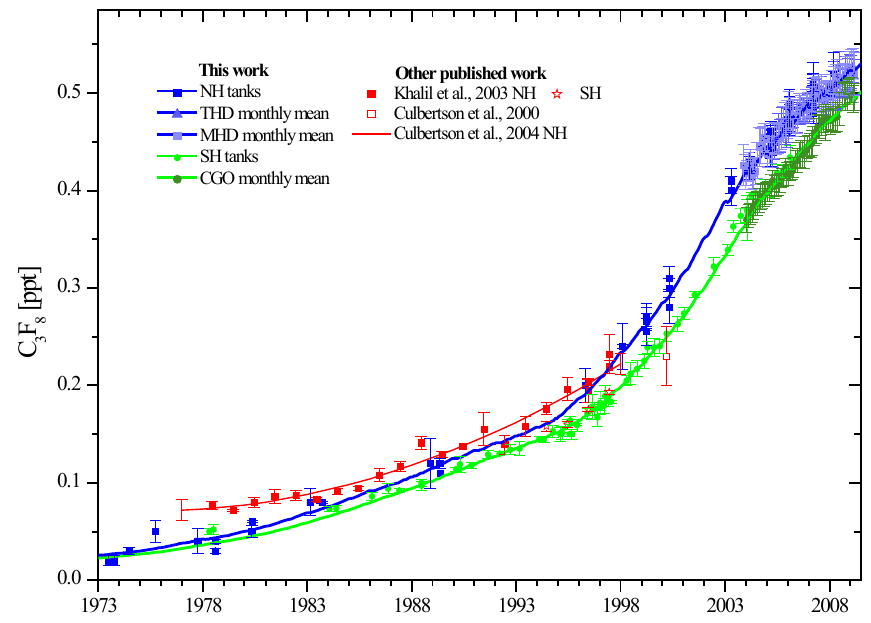
Fig. 3. AGAGE C 3 F 8 abundances from archived Northern Hemisphere (NH) and Southern Hemisphere (SH) air samples and in situ measure- ments at Mace Head, Ireland (NH), Trinidad Head, California (NH), and Cape Grim, Tasmania (SH) and modeled 30–90 ◦ N and 30–90 ◦ S abundances all shown on the SIO-2007 scale compared to previous observations. The SIO-2007 calibration scale uncertainty estimate ( ∼ 1–2%) is similar to the shown